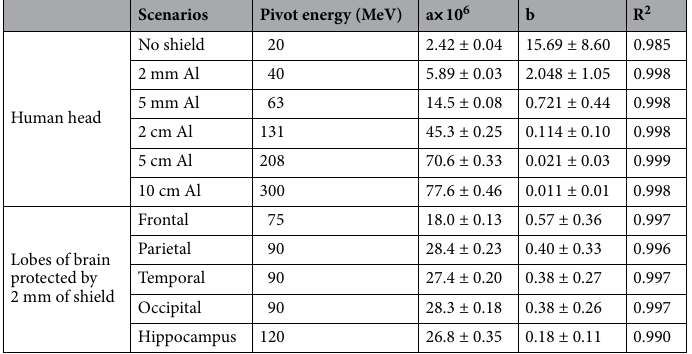
· sr cm 2 MeV and b with